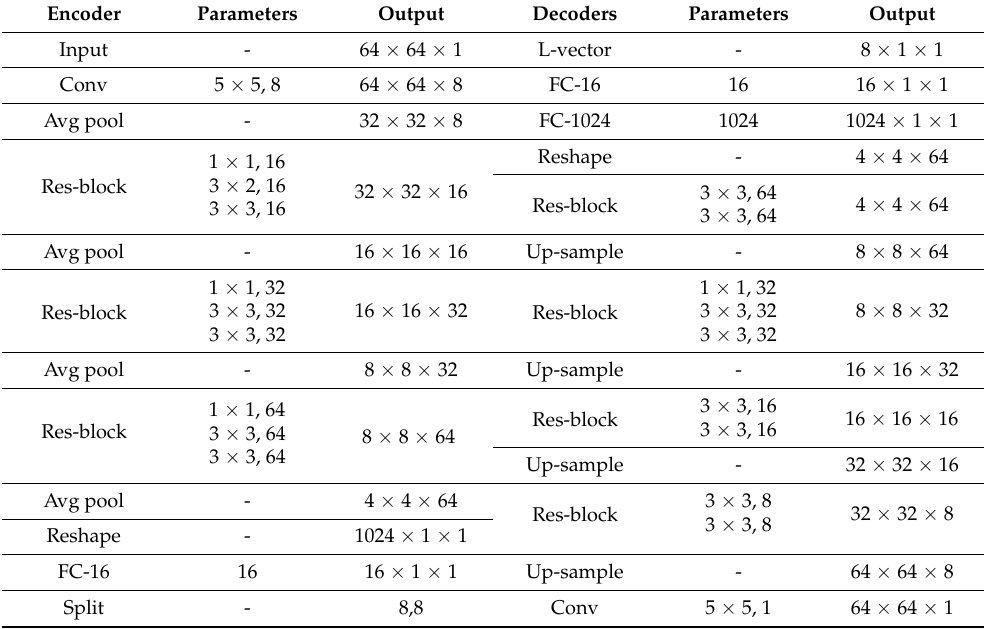
Table 1. Model parameters of encoder and